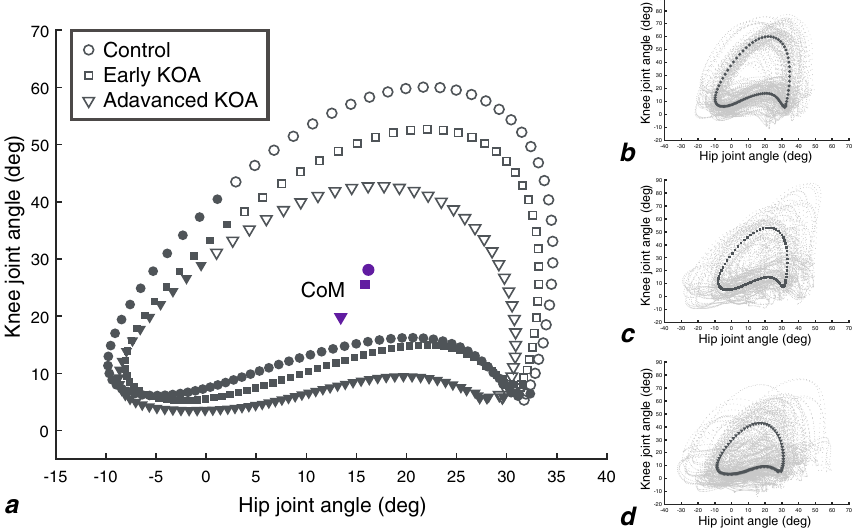
Figure 2. The hip-knee cyclograms of three groups (stance phase shown as filled dot, swing phase shown as empty dot). Mean hip-knee cyclograms of control, early KOA, and advanced KOA groups (a) . All hip knee cyclograms of control (b) , early KOA (c) , and advanced KOA (d) . RoM range of motion, CoM center of mass.